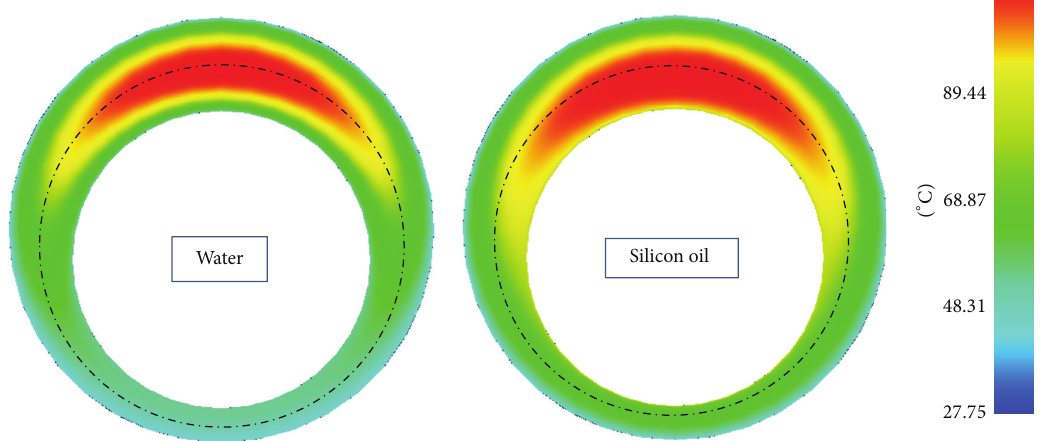
Figure 7: Distribution of temperature at the hollow part section.